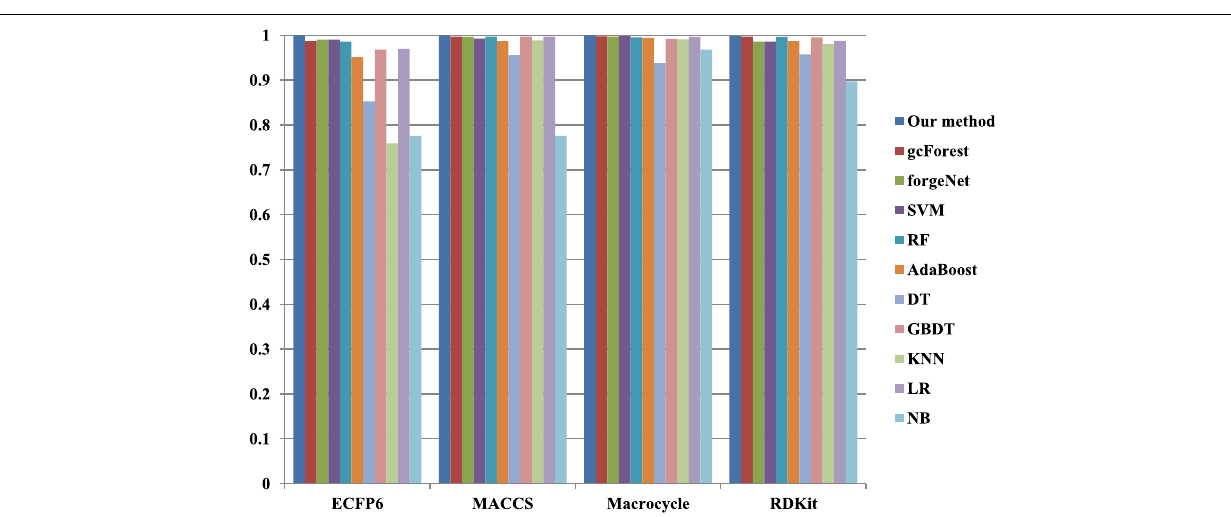
FIGURE 5 | AUC performances of 11 methods with diabetes dataset.